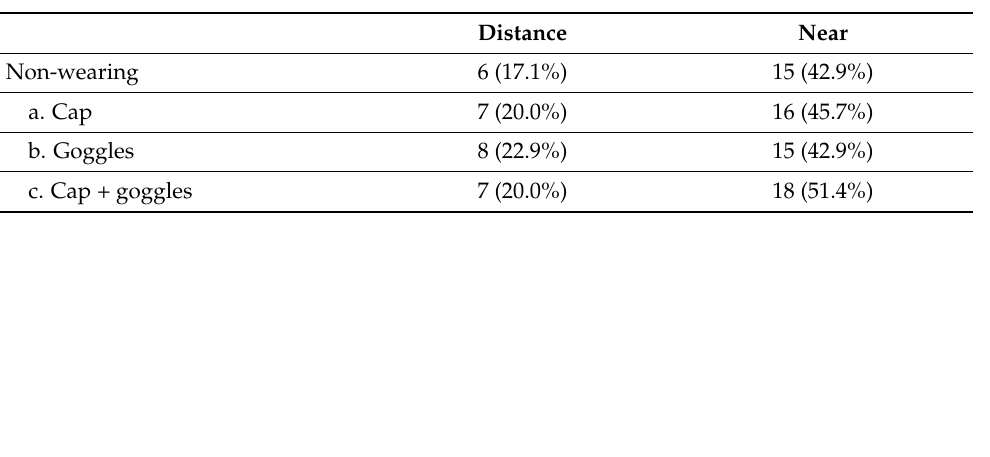
Table 5. Frequency of changes in prism prescription based on Sheard’s